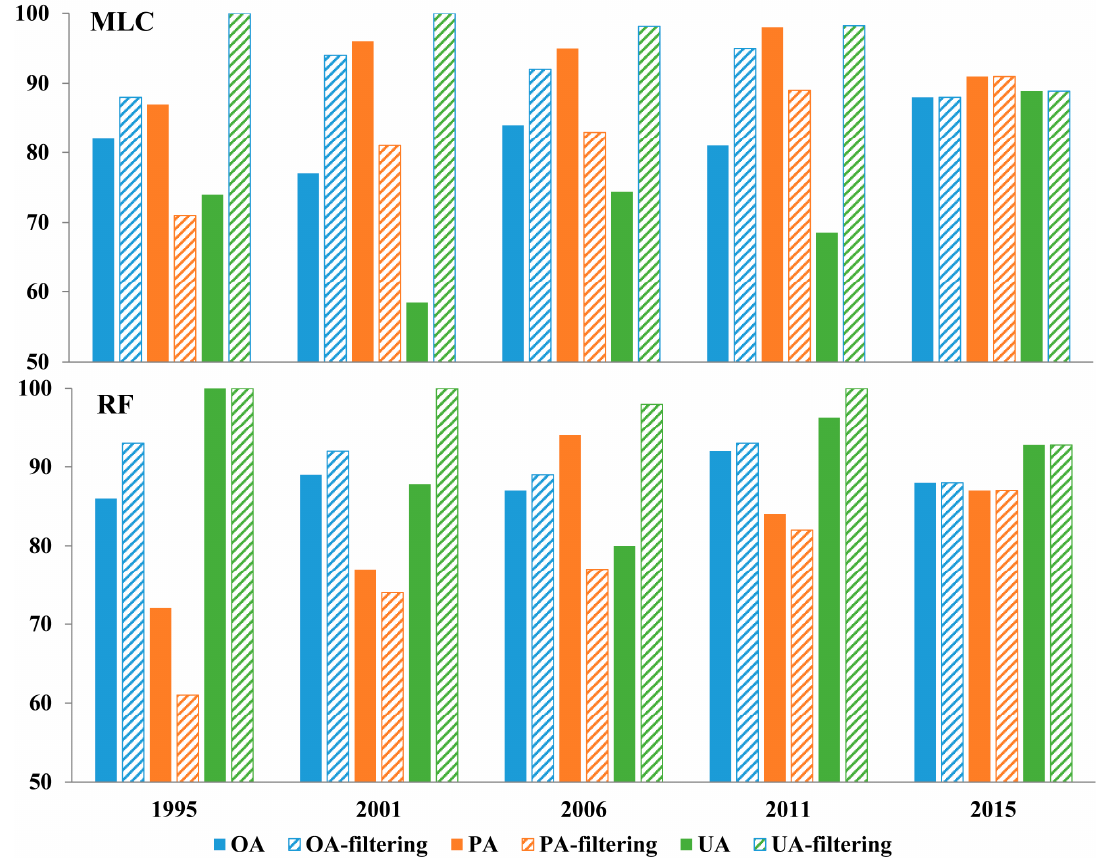
Figure 5. Accuracy assessment results for test years. OA-overall accuracy; PA-producer’s accuracy; UA-user’s accuracy.